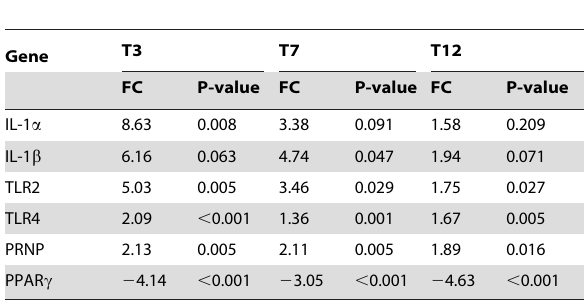
Table 1. P-values and FCs for the target genes at every time